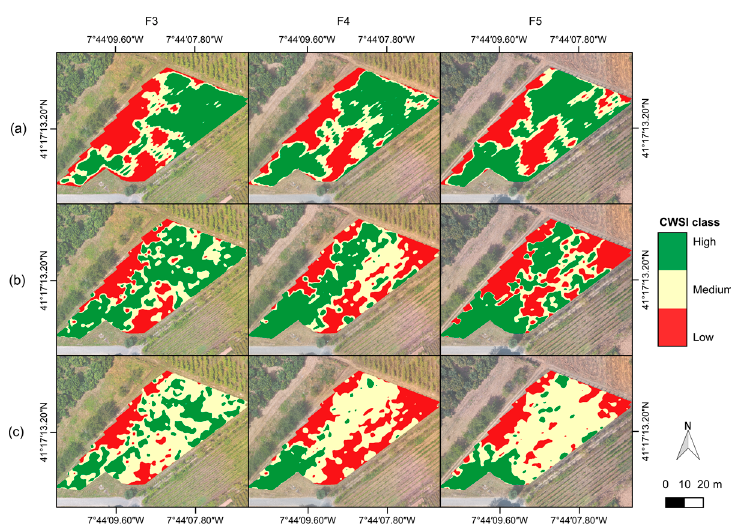
Figure 10. Generated crop water stress index (CWSI) maps for each flight campaign. Each CSWI value was sorted into one of three classes (low, medium, or high). The whole vineyard ( a ), grapevines’ vegetation only ( b ), and normalized grapevines’ vegetation ( c ) was considered.